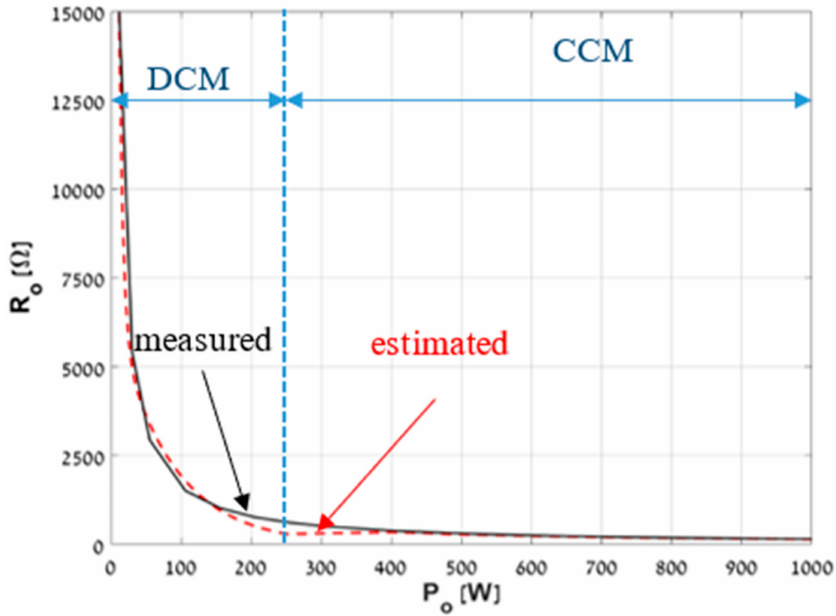
Figure 20. IWPT link measured and estimated output resistance versus load